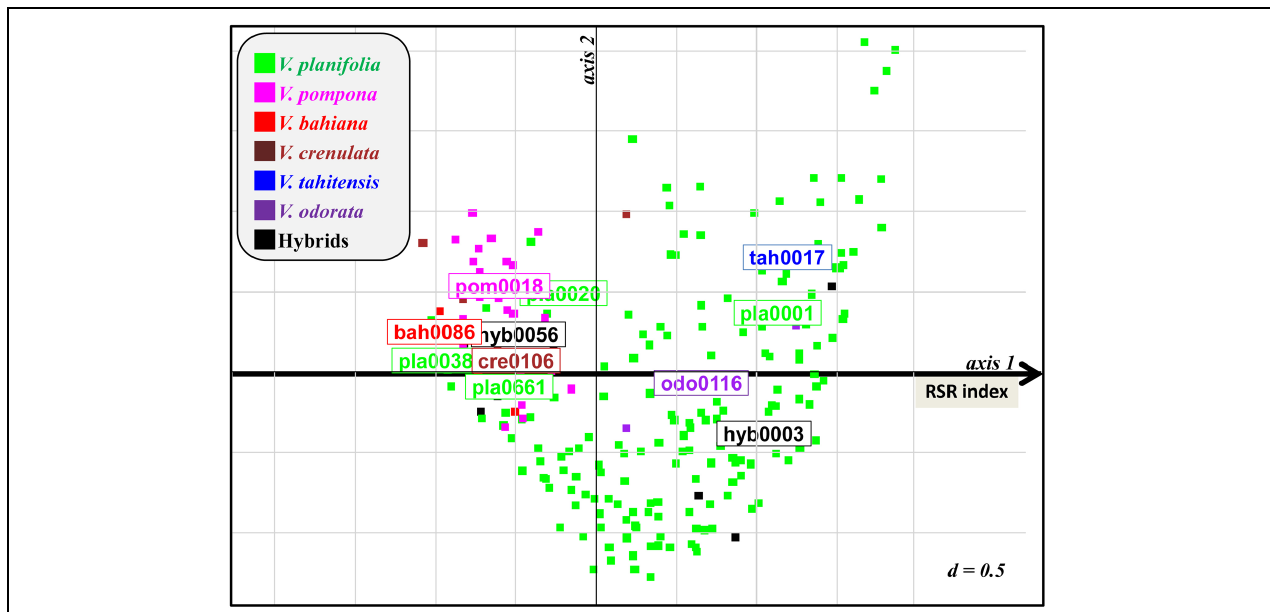
FIGURE 1 | First factorial plane of MCA for 128 vanilla accessions rated for RSR symptoms in the field in 2009 using seven variables (Table 2 and Supplementary Figure S2). Axis 1 segregates accessions according to their resistance level. Remarkable susceptible (on the right) and resistant (on the left) accessions are indicated. RSR index of accessions was defined as their coordinate on axis